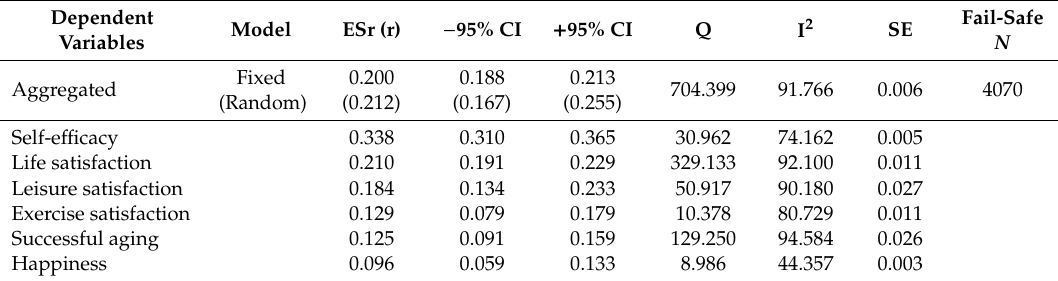
Table 2. E ff ect sizes of physical activity on all subjective well-being outcomes.